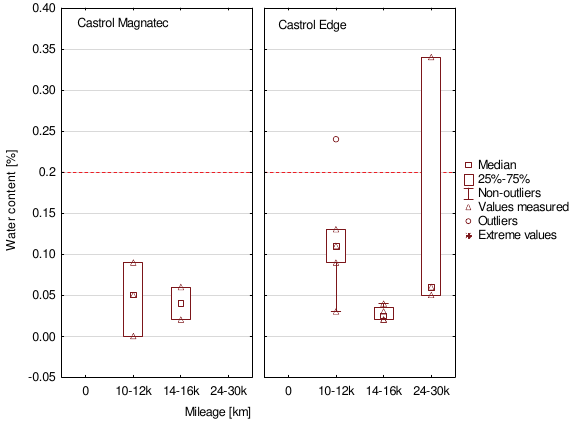
Fig. 8. The water content of the engine oils tested Generally, there should be no glycol in engine oils.